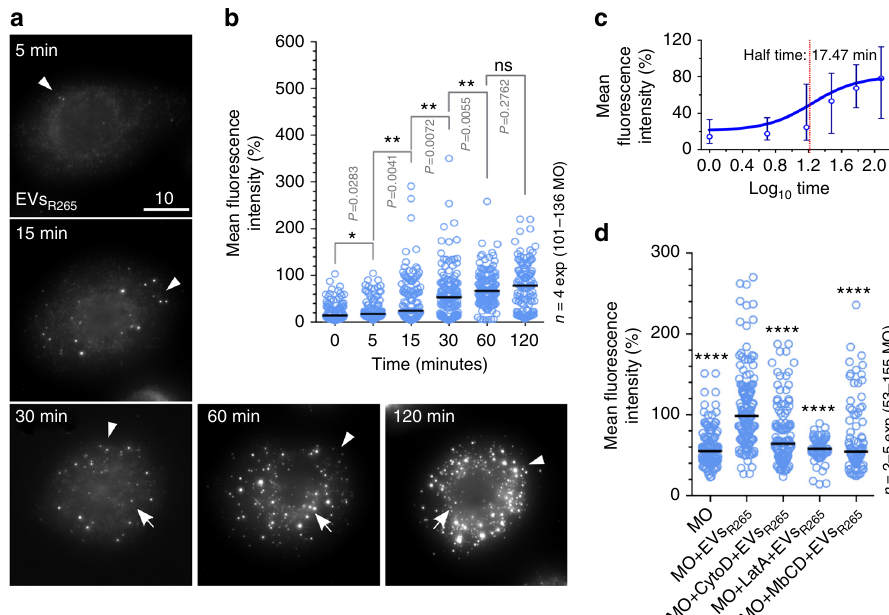
Fig. 5 EVs are rapidly and actively internalised by macrophages. a Macrophages were exposed to 10 μ g of EVs R265 , fi xed with 4% PFA after 5, 15, 30, 60 and 120 min incubation and then immunostained using capsule-speci fi c monoclonal antibody MAb 18B7. Images are maximum projections (21 z-stacks with 0.5 μ m intervals). Note the change in signal from the cell periphery (arrowheads) to the cell body (arrows) in a time-dependent manner. Bar: 10 μ m. b EV uptake increases in a time-dependent manner. Data are presented as scattered dot plots with lines representing their medians. Mean fl uorescent intensities were normalised using the median value at 2 h as 100%. Data are representative of results from four independent experiments with a minimum of 25 macrophages analysed per sample per experiment. Unpaired Mann − Whitney tests where * ( P ≤ 0.05), signi fi cant difference; ** ( P ≤ 0.01), signi fi cant difference; and ns ( P > 0.05), not signi fi cantly different. c Half time determination of EVs uptake by J774 macrophages. Data are presented as a sigmoidal non-linear regression curve (four-parameter logistic curve) with medians and errors (interquartile range) obtained from four independent experiments (from Fig. 5b). d The uptake of EVs by J774 macrophages is blocked by actin polymerisation inhibitors, cytochalasin D (MO + CytoD + EVs R265 ) and latrunculin A (MO + LatA + EVs R265 ) or a lipid raft-speci fi c inhibitor methyl- β -cyclodextrin (MO + MbCD + EVs R265 ), which depletes cholesterol. Data are presented as scattered dot plots with lines representing their medians. Graph showing percentages of mean fl uorescent intensities from macrophages alone (MO) or incubated with MAb 18B7-immunostained EVs isolated from R265 (MO + EVs R265 ) and were normalised to a median value obtained for MO + EVs R265 . Data are representative of results from 2 to 5 independent experiments with a minimum of 25 macrophages analysed per sample